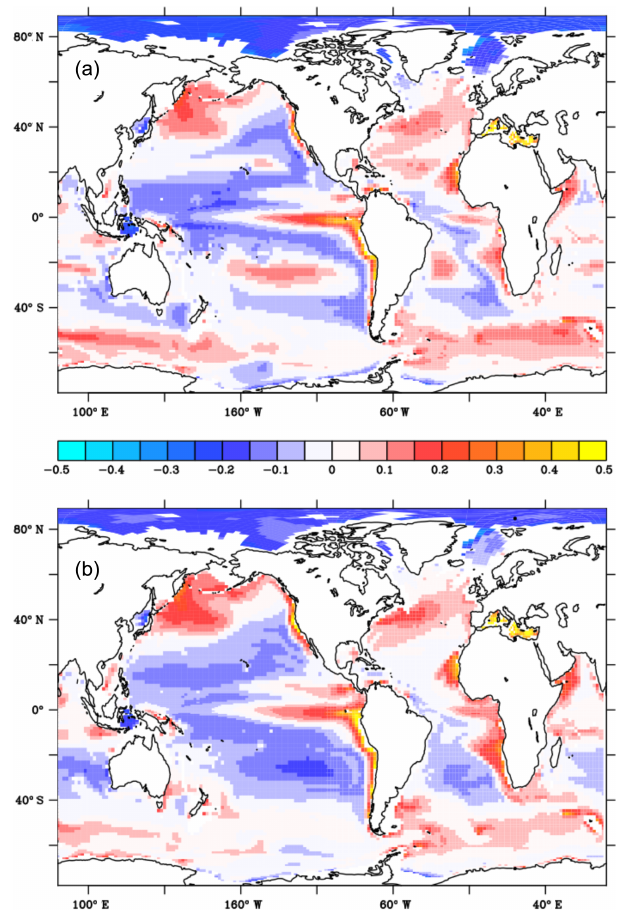
Figure 10. Spatial variations of the annual mean anomalies of the remineralisation coefficient b from the global median value: (a) from the noRC experiment and (b) from the RC experiment. The global median values of b are 0.87 and 0.7 in the noRC experi- ment and in the RC experiment respectively. b has been determined by fitting a power law function to the modelled vertical profiles of total particulate carbon between the bottom of the photic zone and